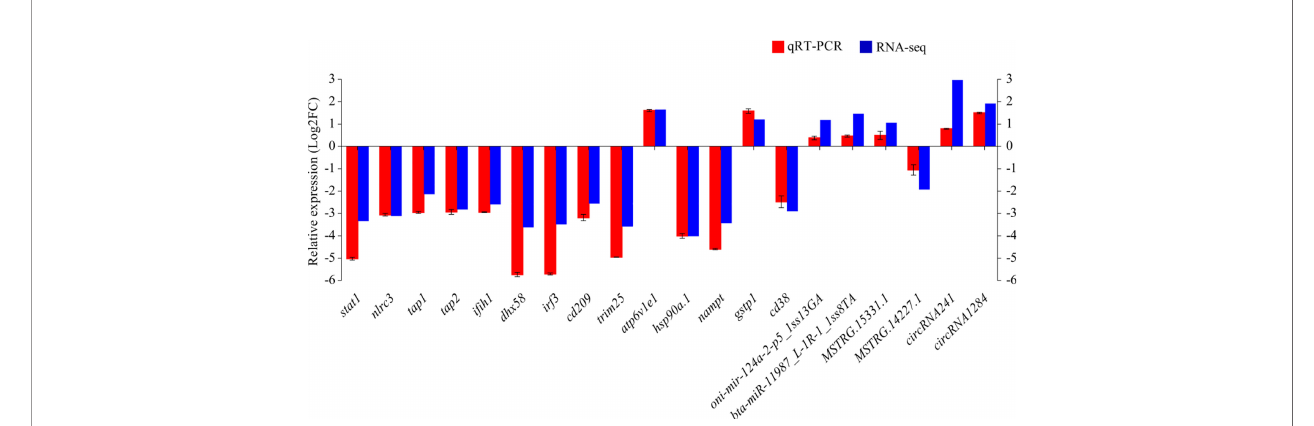
FIGURE 9 | The differential expression of mRNAs and ncRNAs in RNA-seq was validated by qRT-PCR. Fold-change of qRT-PCR data represents the ratio of target gene expression values for YR_S vs. WR_S after normalization against b -actin